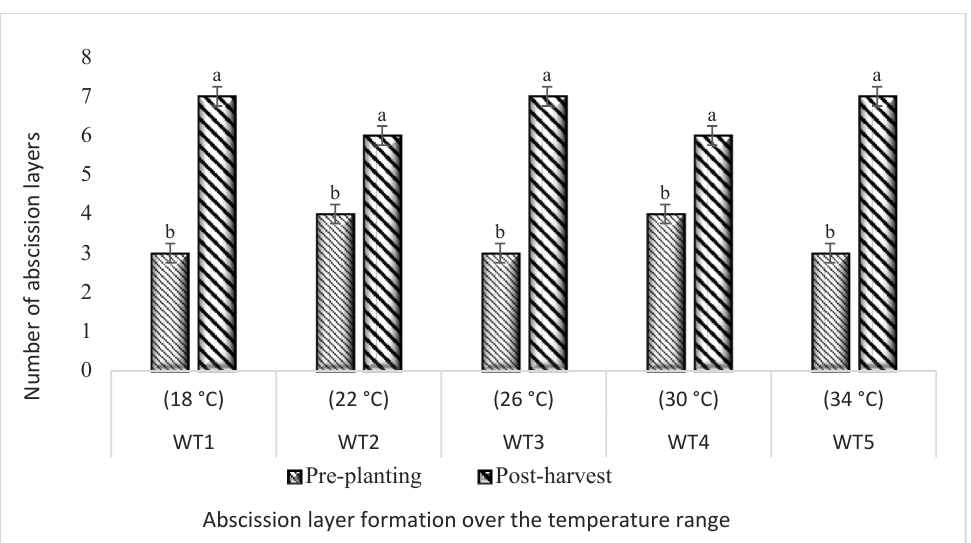
Figure 8. The correlation between all root zone water temperature treatments and the decrease in abscission layers that were present at the start, as compared to the complete absence of abscission layers at the end of the study. Note: Bar graphs presented here are means of the number of abscission layers ±SE. The mean values followed by the same letters are not significantly different (ns) at p ≤ 0.05 as calculated by Fisher’s least significant difference.